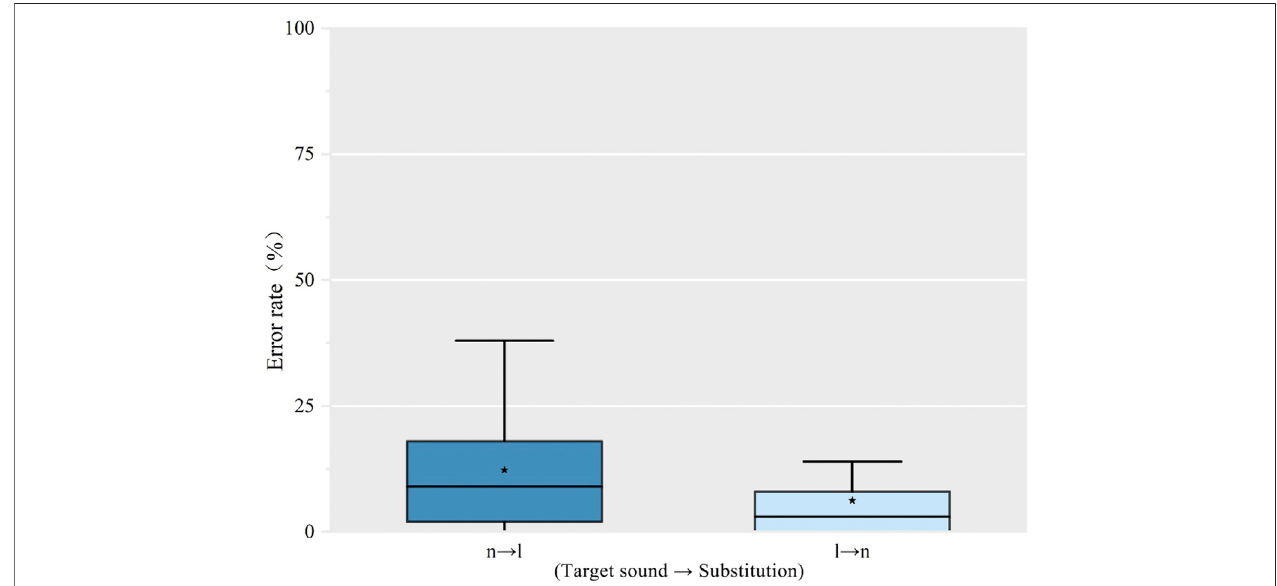
FIGURE 4 | Error rate of production of Standard Mandarin disyllabic words with initial /n/ and /l/.